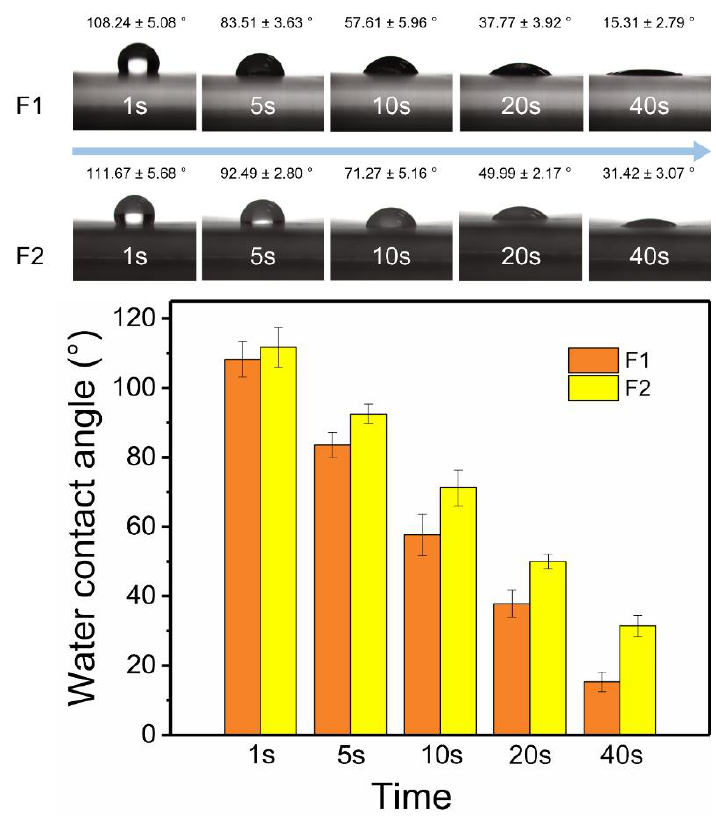
Figure 4. Water contact angles of F1 and F2 fibers in 40 s.